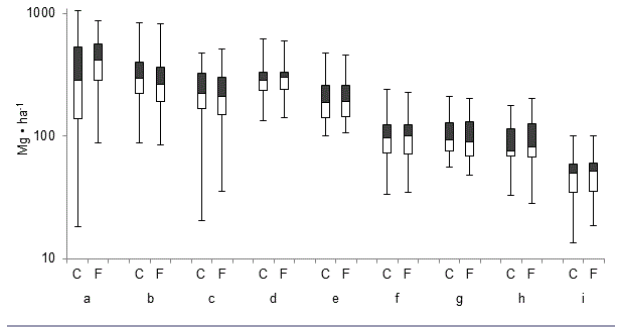
Fig. 2 . Comparison of woody biomass data in diverse Southeast Asian forests compiled by community members and professional foresters. Measurements of aboveground woody biomass were made by community members (C) and foresters (F) over a range of lowland dipterocarp forest in Batu Majang, Indonesia (a), mountain rainforest in Manlin, China (b–c), evergreen monsoon forest in Sakok, Laos (d– e), and Diem (f) and Moi (g–i), Vietnam ( n = 289 permanent plots; log10 scale). The different points in each column show the smallest observation, lower quartile, median, upper quartile, and largest